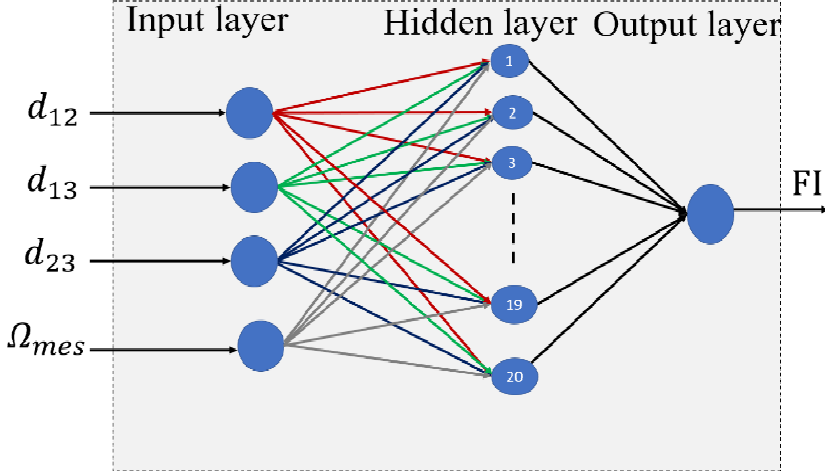
Figure 11. The structure of the multilayer feed-forward back-propagation neural network.